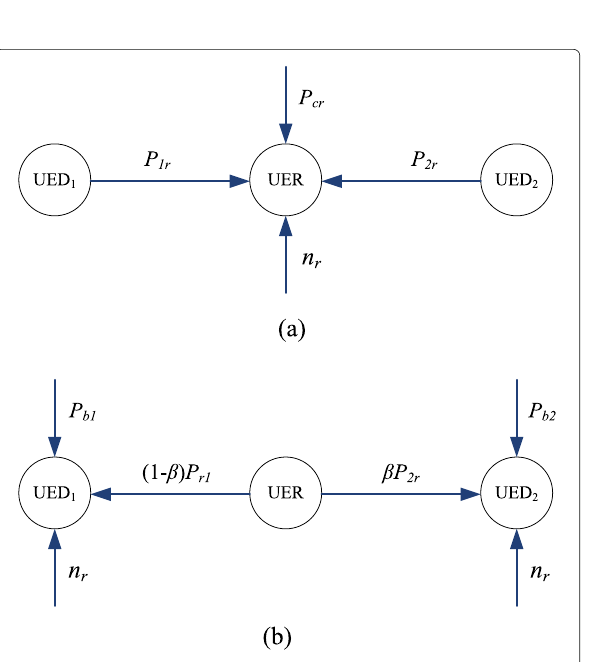
Fig. 2 The three-node model with interference and noise. a The first time slot and b the second time